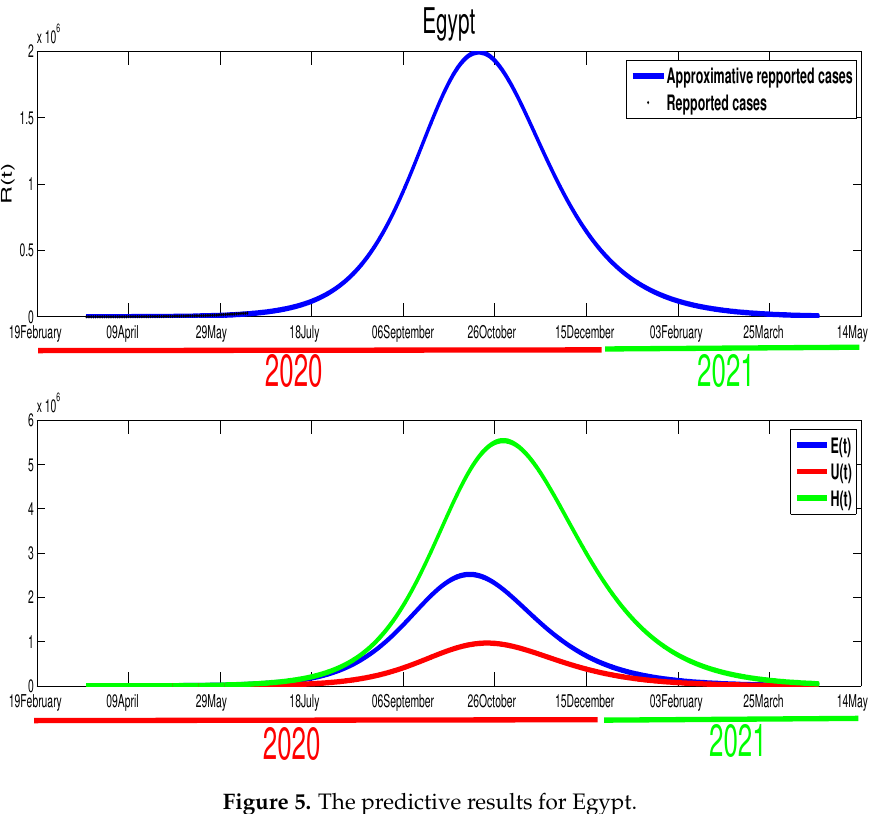
Figure 5. The predictive results for Egypt.